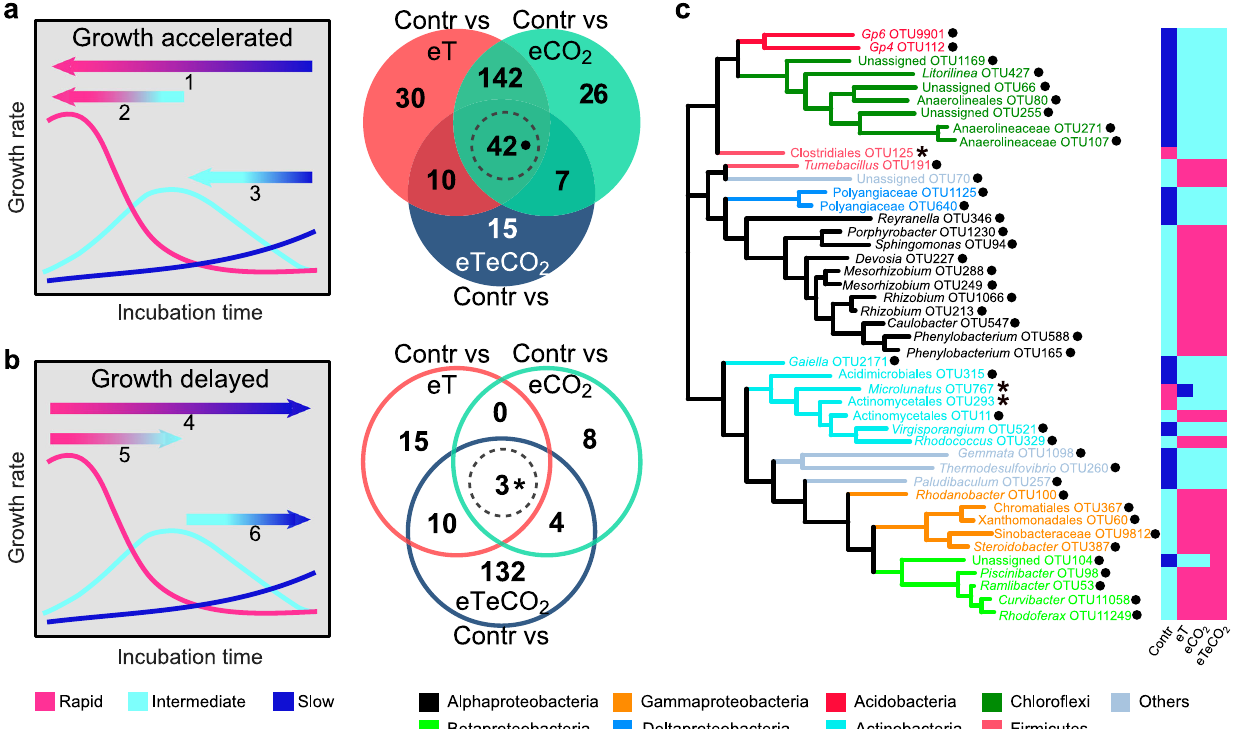
Fig. 4 | Climate change shifted growth strategies of soil bacteria. Microbial growth accelerated ( a ) or delayed ( b ) by climate change. The ‘ growth accelerated ’ included three situations, (1) microbial growth strategies changed from slow to rapid, (2) from intermediate to rapid, and (3) from slow to intermediate when comparing ambient conditions (Contr) with the other three climate treatments; The ‘ growth delayed ’ shift included the changed strategies (4) from rapid to slow, (5) from rapid to intermediate, and (6) from intermediate to slow. Veen plots showedtheoverlapsoftaxawithchangedstrategiesamongthecomparisonsofthe three climate change scenarios with Contr. Closed circles: growth accelerated;